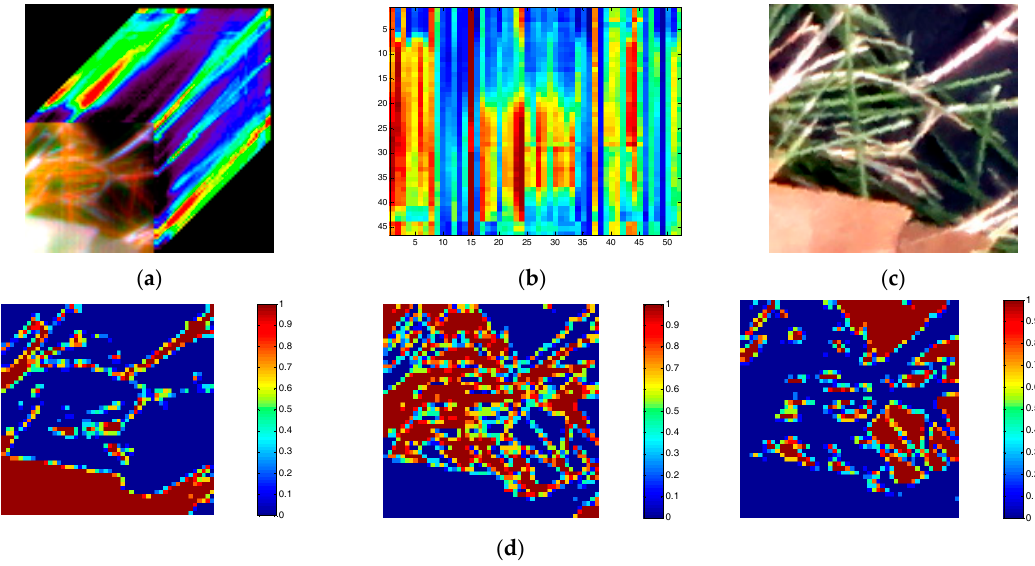
Figure 6. Nuance data: ( a ) Nuance data; ( b ) Spectral_lib; ( c ) Higher-Resolution RGB image (HR) data; and ( d ) the approximate reference abundances, from left to right: dead leaves, fresh grass, background.